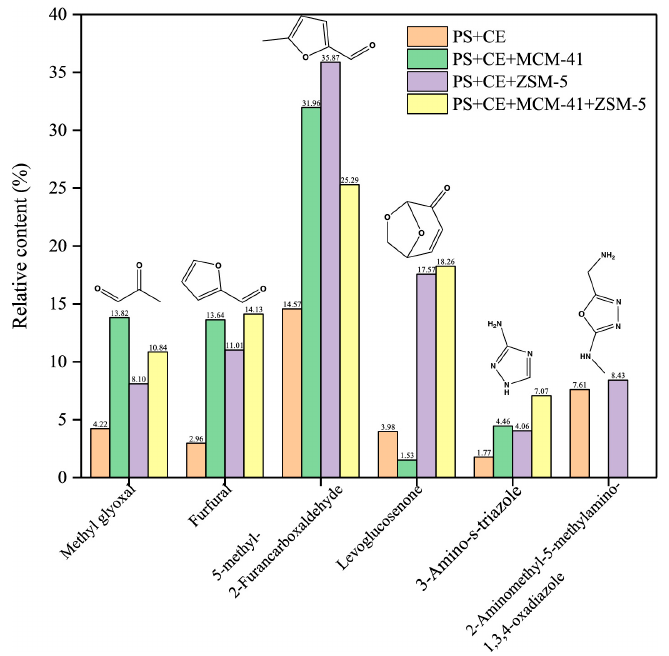
Figure 5. Comparing non-catalytic soluble polysaccharides and CE with different zeolite catalysts MC-41, ZSM-5 and their mixtures [62]. Copyright, 2022, Wiley & sons.